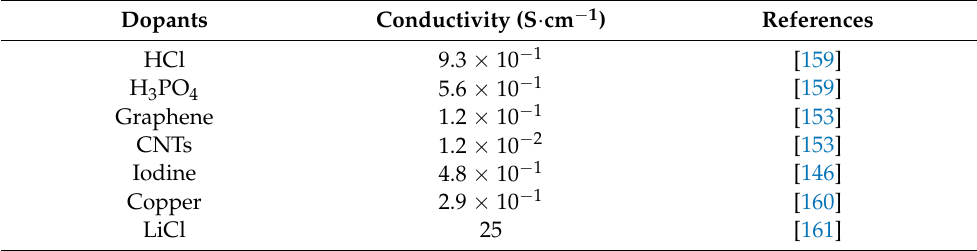
Table 9. Conductivity measurement of PANi synthesized with various types of acid dopants.